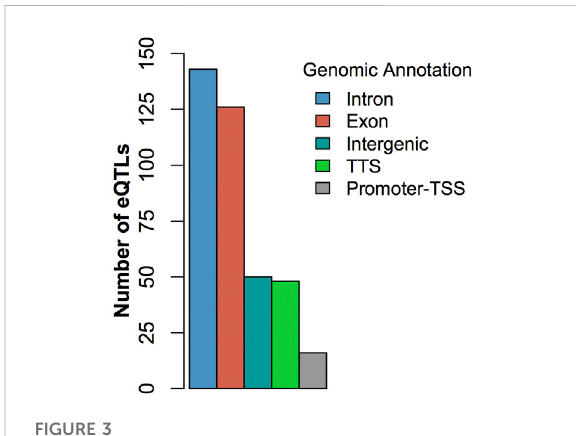
FIGURE 3 Histogram of the distribution of eQTLs by genic